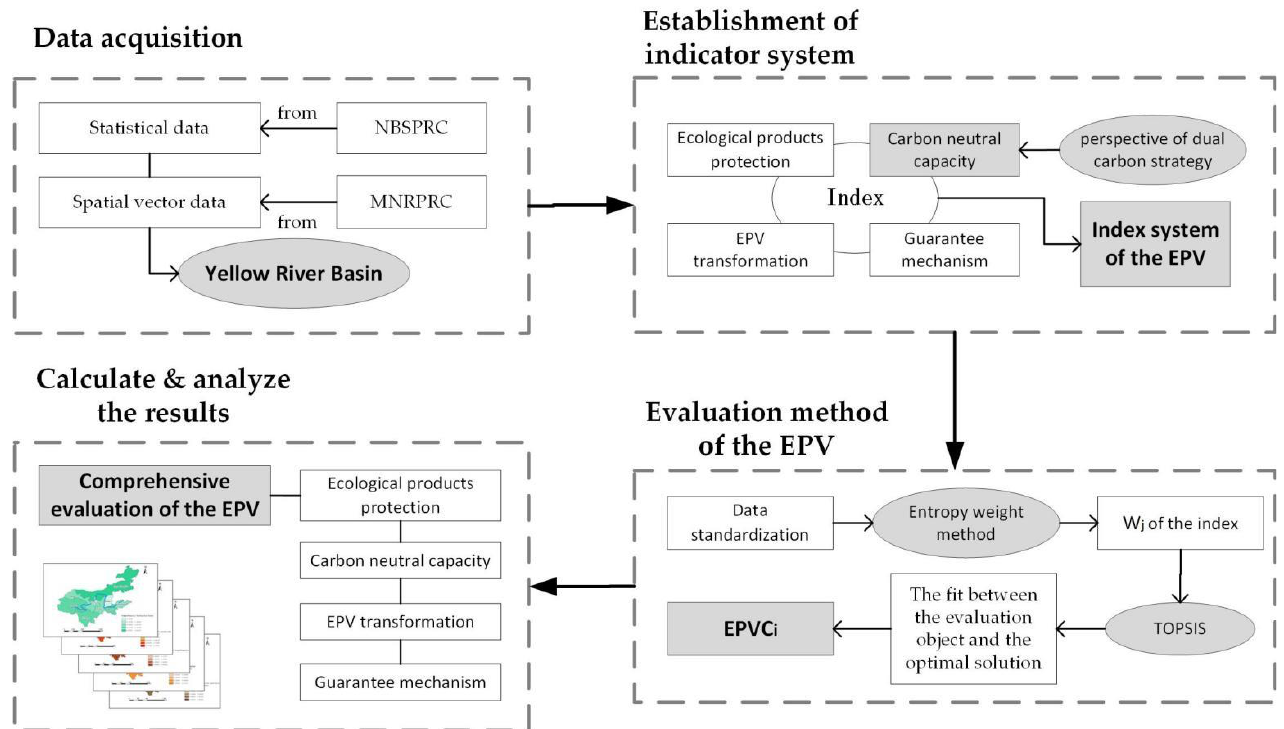
Figure 1. Methodological flow diagram.